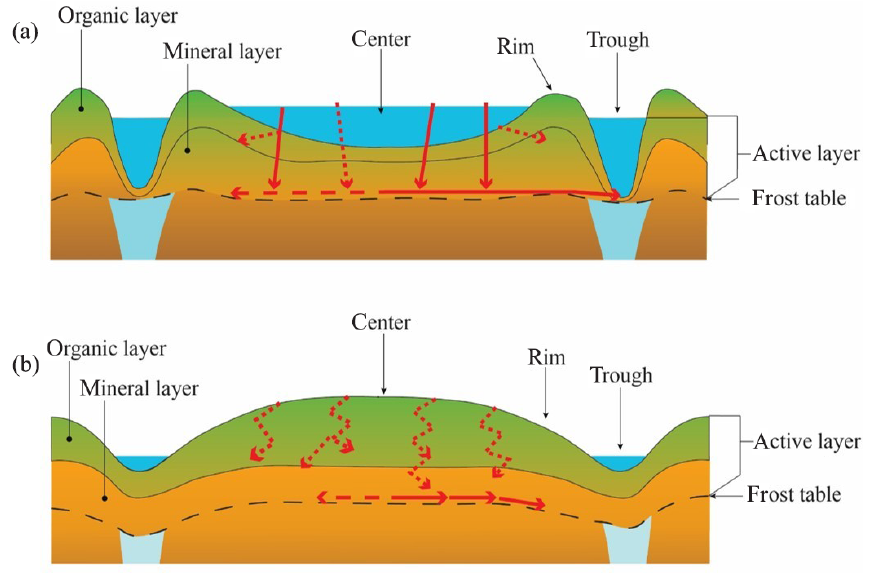
Figure 13. Conceptual diagram of tracer transport in ice-wedge polygons. Red arrows indicate transport pathways. Length of arrow indicates relative flux. Dashed arrows indicate lower rates of flux than solid